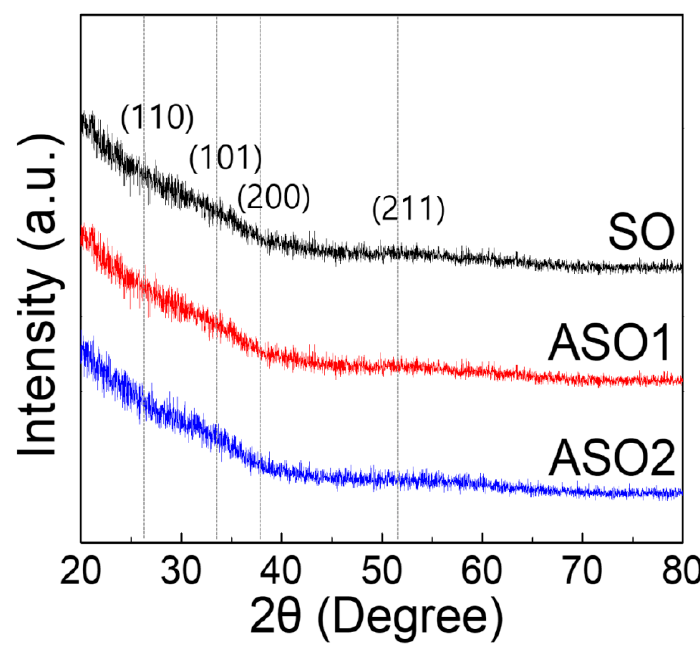
Figure 4. High resolution X ‐ ray diffraction (HR ‐ XRD) patterns of SO, SAO1, and SAO2 thin ‐ films with different Al concentrations.